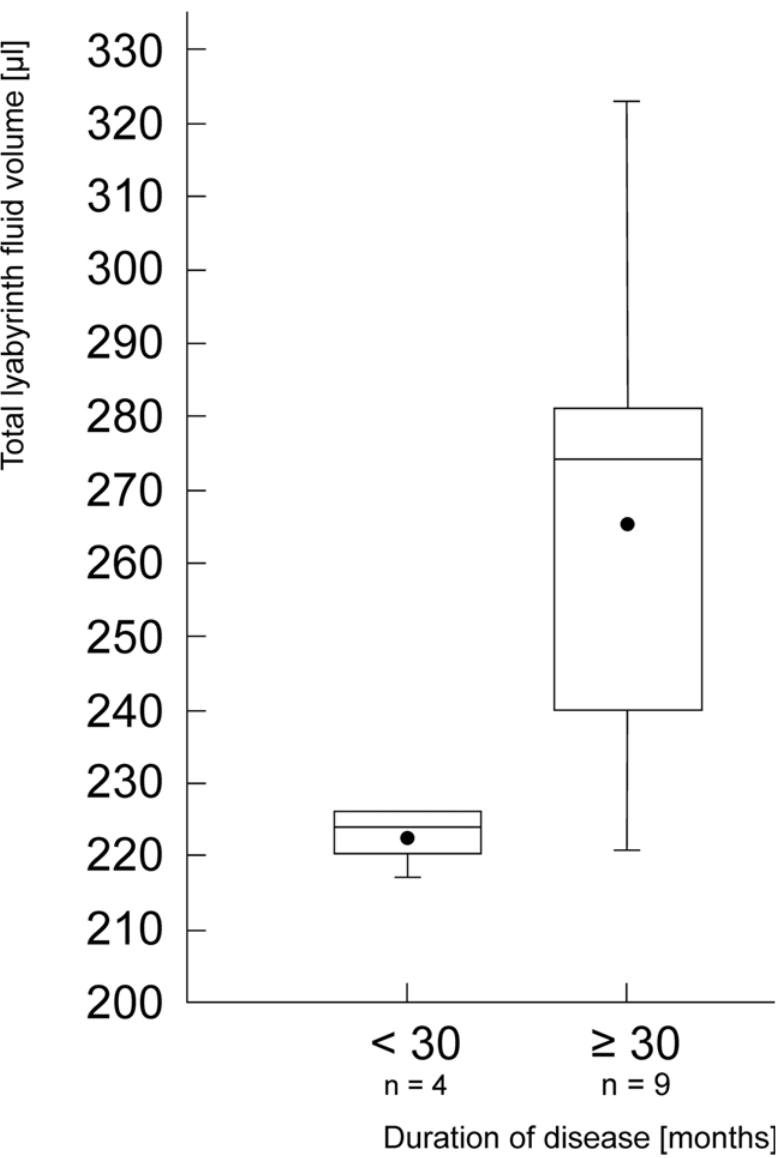
Fig 3. Influence of the duration of disease on the total labyrinth fluid volume in ears affected by endolymphatic hydrops. The box depicts the lower and upper quartile as well as the median; the black dot represents the mean. The whiskers depict a maximum and minimum of 1,5x of the interquartile range, statistical outliers are expressed as small circles. The difference between both groups was considered significant (p <